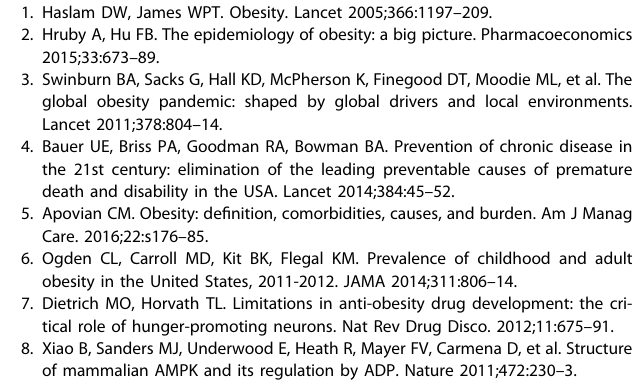
Fig. 7 Ela treatment accelerates glucose consumption and fatty acid oxidation. A RNA-seq data of primary hepatocytes treated with DMSO or 0.5 μ M Ela for 6 h showed that Txnip was downregulated, while Glut1 and multiple metabolic enzymes involved in glucose consumption and fatty acid oxidation were upregulated by ELA treatment. B Primary hepatocytes were treated with DMSO or 0.5 μ M Ela for the indicated time. mRNA levels of Txnip , Glut1 , and several metabolic enzymes after treatment were quanti fi ed by qRT-PCR. C Primary hepatocytes and the mature adipocytes were treated with 0.5 μ M Ela for the indicated time. Cells were then lysed and applied for WB. D Primary hepatocytes were treated with 0.5 μ M Ela for the indicated time. Intracellular intermediates involved in glycolysis, TCA cycle, and amino acid metabolism were determined by GC – MS. The schematic diagram of metabolic fl ux that included those metabolites is shown. E Primary hepatocytes were treated with Ela at the indicated concentration for 1 h. Intracellular intermediates involved in glycolysis, TCA cycle and amino acid metabolism were determined by GC – MS. The schematic diagram of metabolic fl ux that included those metabolites is shown. F, G Heat map of metabolites detected in 3D and 3E. Data are expressed as mean ± SEM. * P < 0.05, ** P < 0.01, *** P < 0.001 for the indicated comparisons by one-way ANOVA with Tukey tests, except for A , two-tailed unpaired Student ’ s t